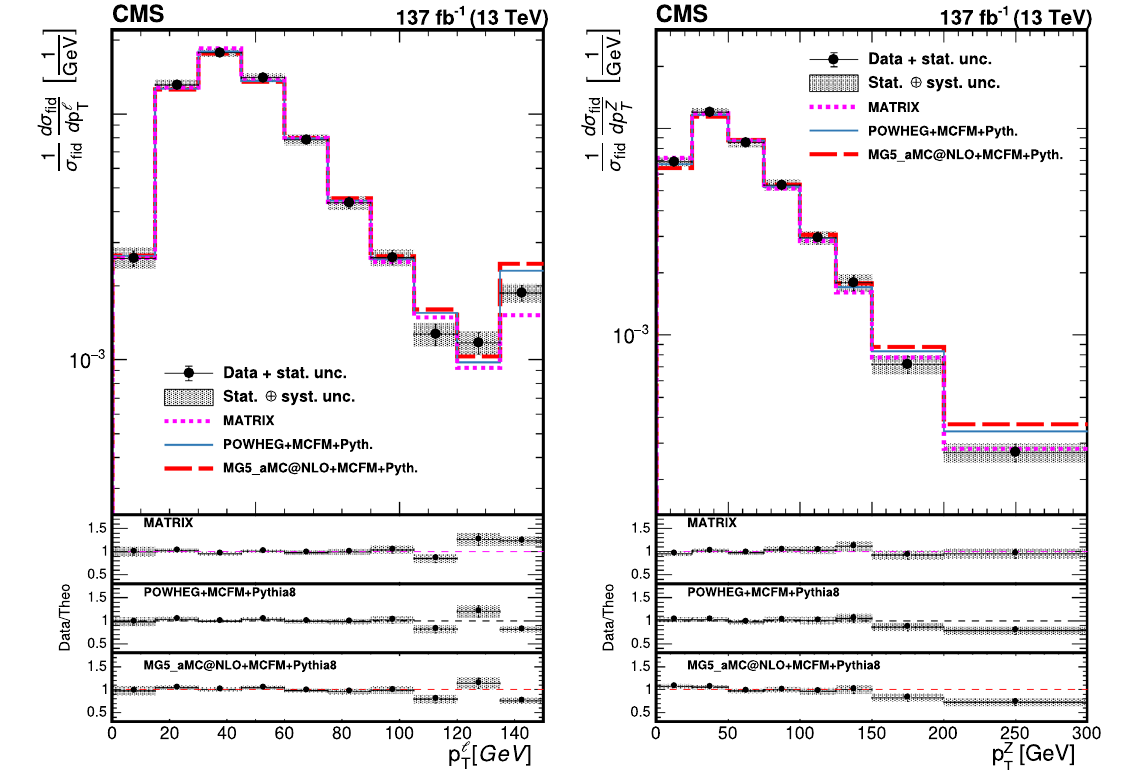
Graph 5_a mc@nlo + mcfm calculations. The three lower panels repre- sent the ratio of the measured cross section to the expected distributions from Matrix , powheg + mcfm and MadGraph 5_a mc@nlo + mcfm . The shaded areas in all the panels represent the full uncertainties calcu- lated as the quadratic sum of the statistical and systematic uncertainties, whereas the crosses represent only the statistical